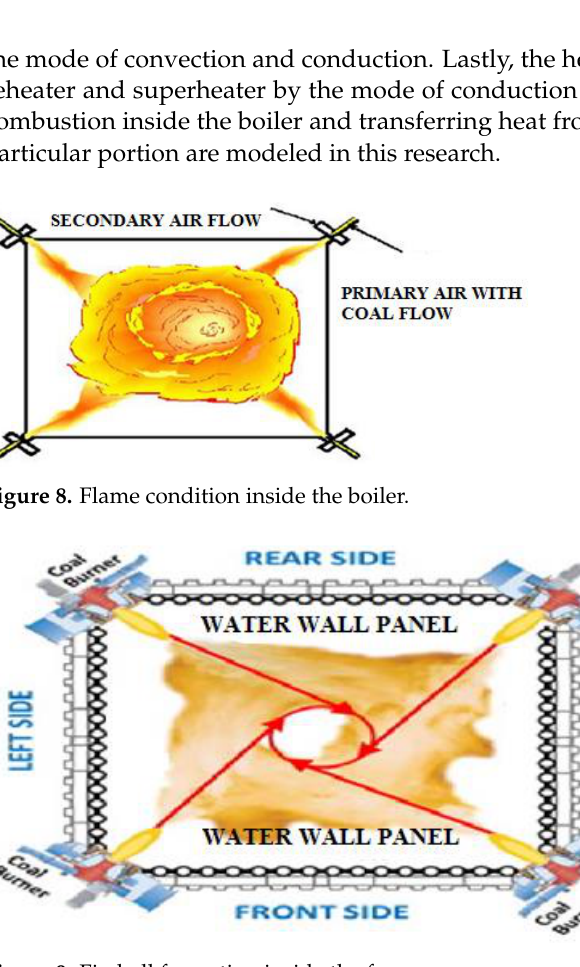
Figure 9. Fireball formation inside the furnace.